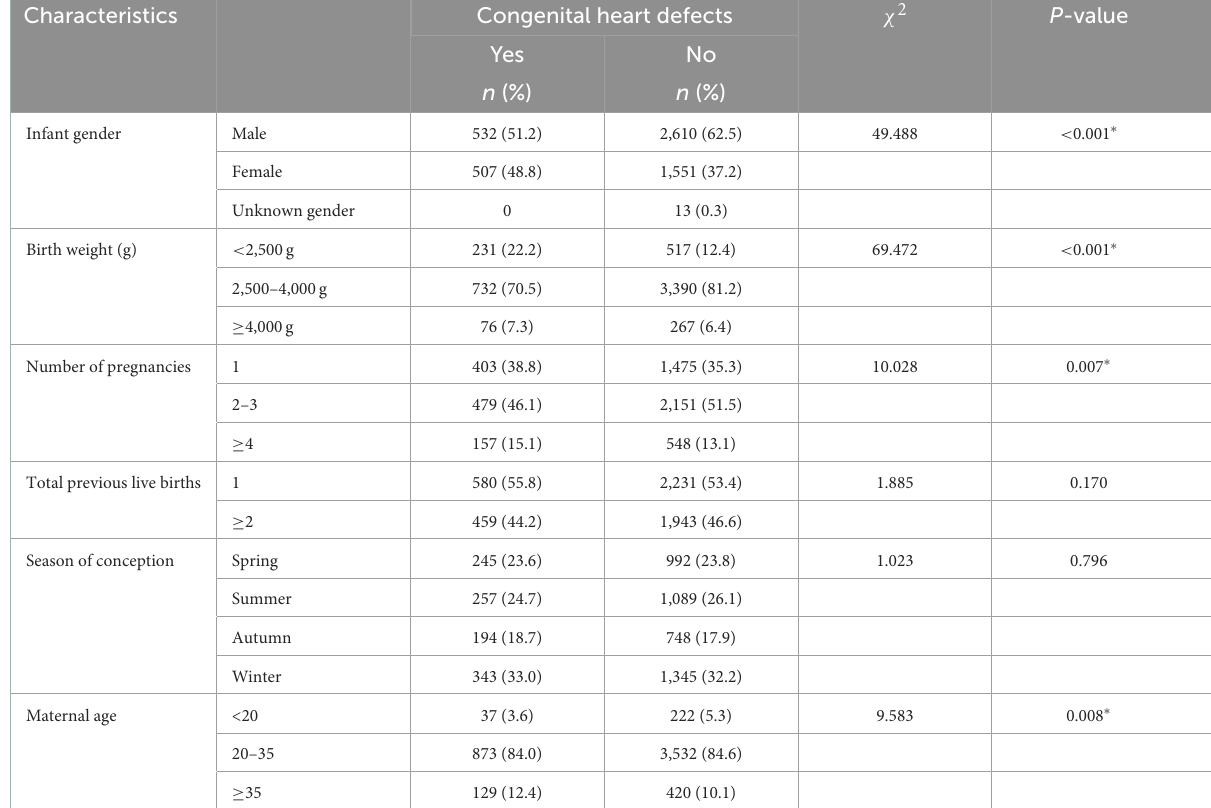
TABLE 2 Distribution of demographic characteristics of children with birth defects.